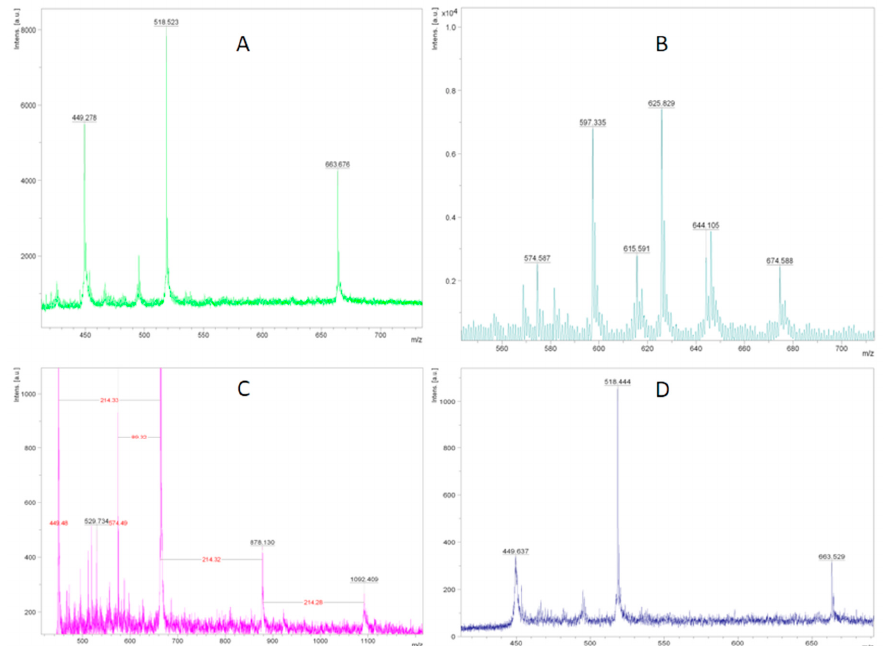
Figure 1. MALDI-TOF (matrix-assisted laser desorption/ionization with time of flight mass spectrometry) spectra of lignin extracts after pretreatment of Miscanthus plant by different methods: ( A ) Method A—NaOH; ( B ) method B—CH 3 COOH/H 2 O 2 ; ( C ) method C—benzoic acid/H 2 O 2 ; ( D ) method D—TFA/H 2 O 2 .